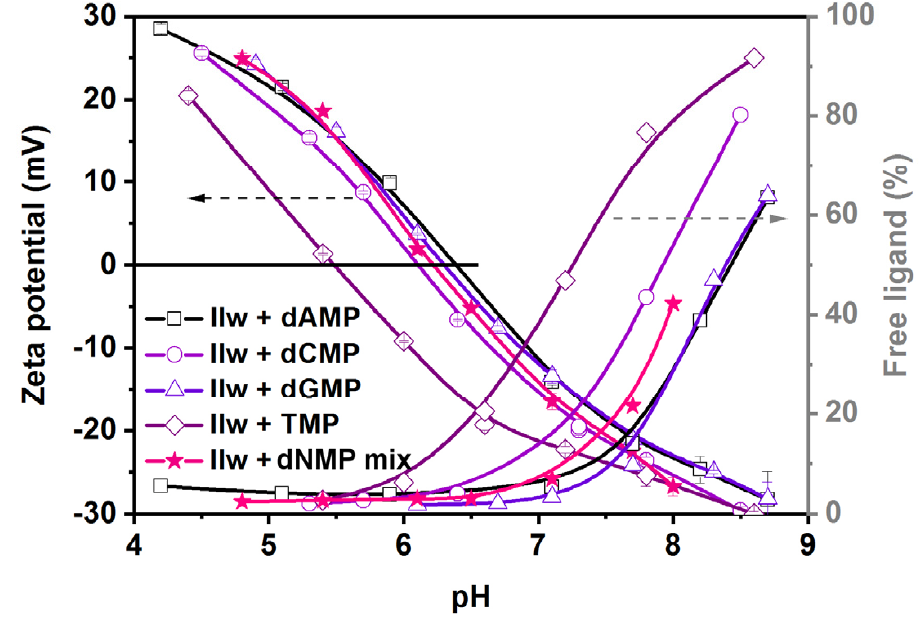
Figure 5. Variation of zeta potential ( left axes ) and the percentage of free ligands ( right axes ) in the function of pH for single-component dNMP solutions and a four-component dNMP mixture. The resulting IEP was 6.3 ± 0.2 for all, except for TMP ligand, whose adsorption took place at lower pH, below pH 7. For the three other single components and the dNMP mixture, the adsorption was almost complete at pH below 7.5.